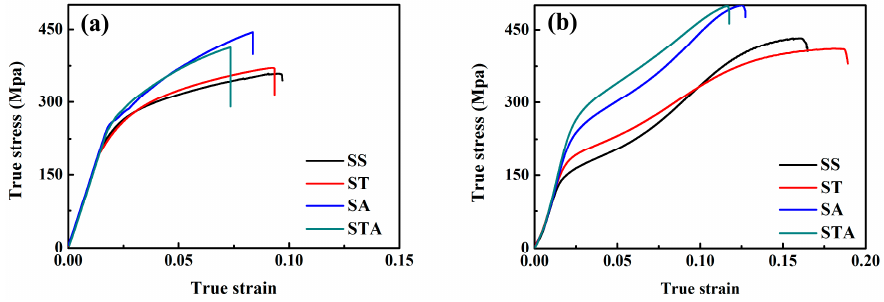
Table 3. Yield strength (YS), peak strength (PS), uniform elongation (UE) and CYS/TYS of various samples.